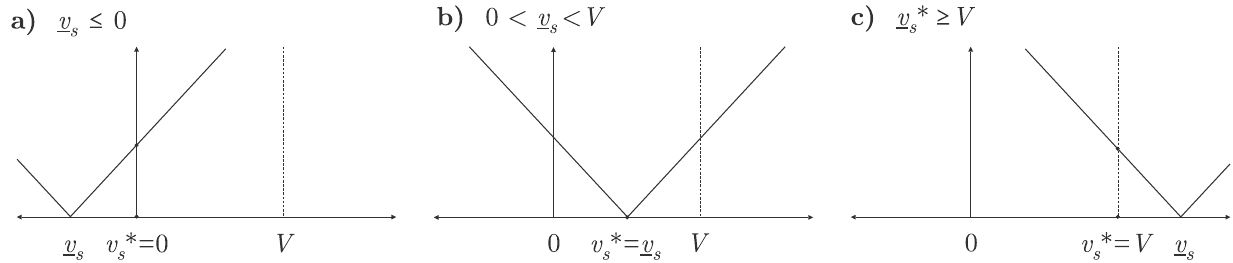
Figure 1. Solutions to the social planner’s problem: ( a ) if v s ≤ 0 , all available vaccines should be given to those who can work from home in order to avoid layoffs among on-site workers. ( b ) If 0 < v s < V , then v ∗ s = v s , which means that there is no unemployment among healthy workers. ( c ) If v s ≥ V all vaccines should be given to on-site workers to minimize unemployment among healthy remote